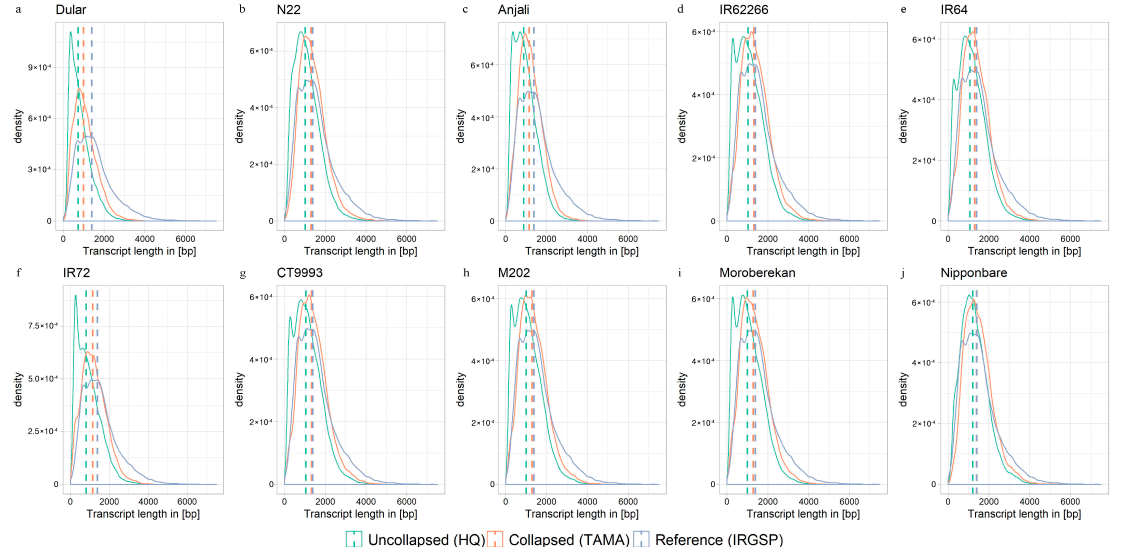
Figure A2. Transcript length distribution for ten Oryza sativa L. ( Poaceae ) cultivars. Length distribution of uncollapsed transcripts is indicated in green, length distribution of transcripts after collapsing by TAMA is indicated in orange and length distribution of the Nipponbare IRGSP reference transcriptome is indicated in purple. Dashed lines show the median length of transcripts for the respective datasets.